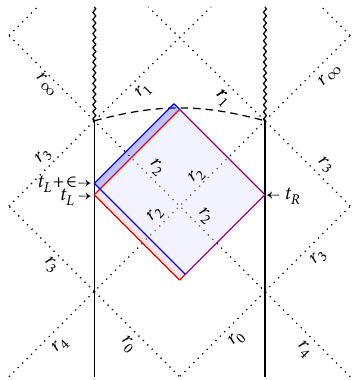
Figure 1: Penrose diagram for a two sided black hole with multiple horizons in which WDW patch evolves at late time approximation and terminates at meet point with t infinity and the wavy lines indicate the singularities at r = 0, also r stands for r =